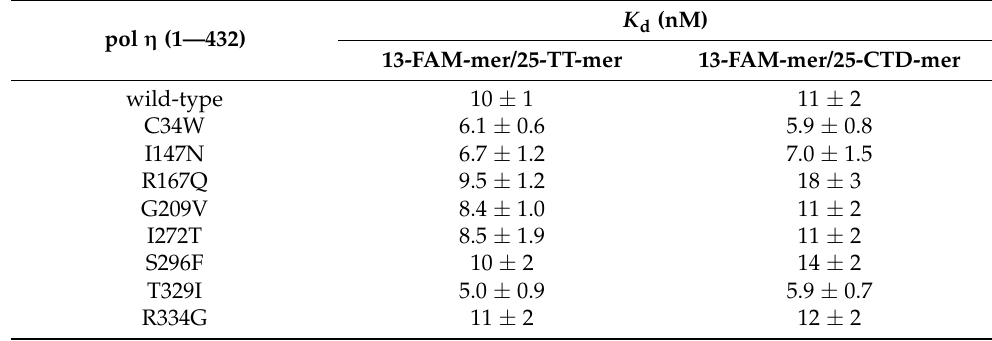
Table 3. DNA binding affinities of human wild-type pol η (1—432) and